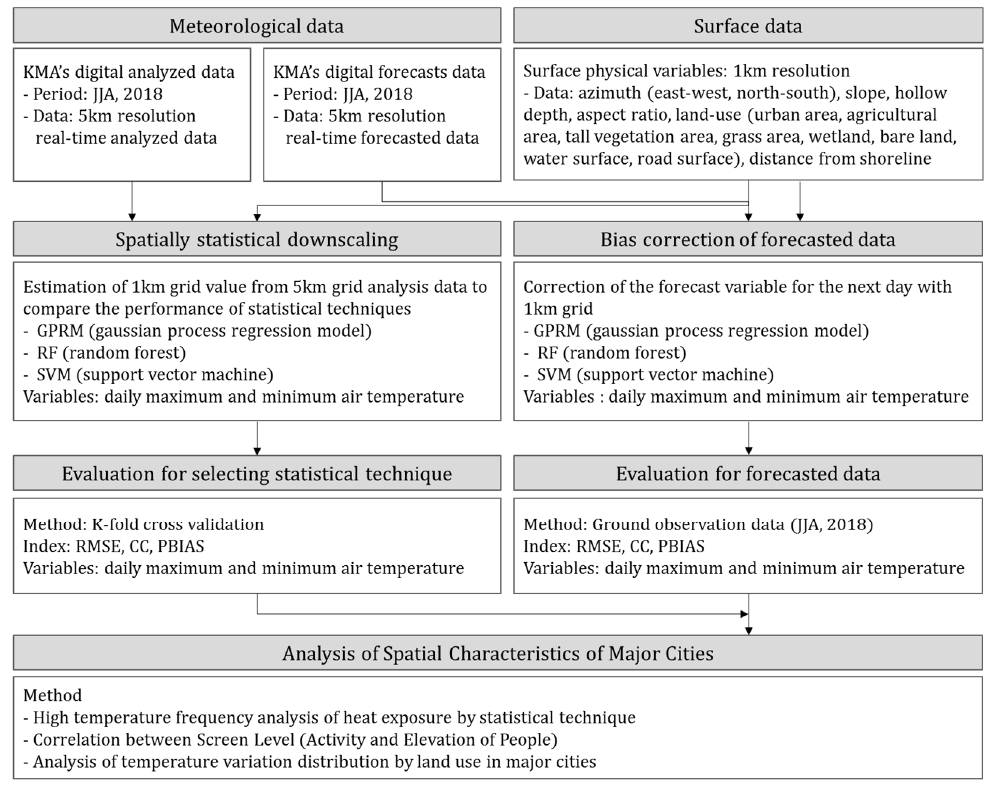
Figure 3. Research flow diagram.